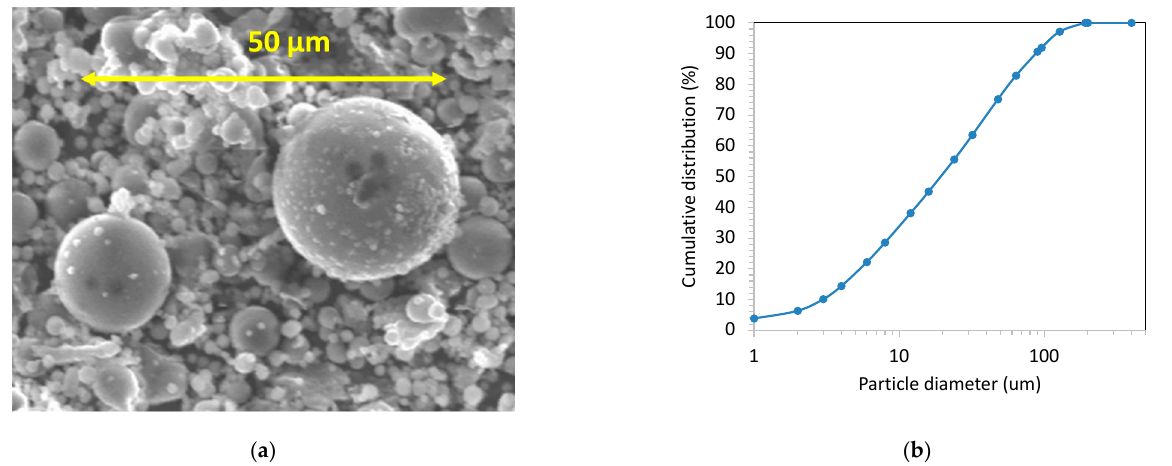
Figure 1. Coal fly ash: ( a ) Scanning electron microscope image; ( b ) particle size distribution